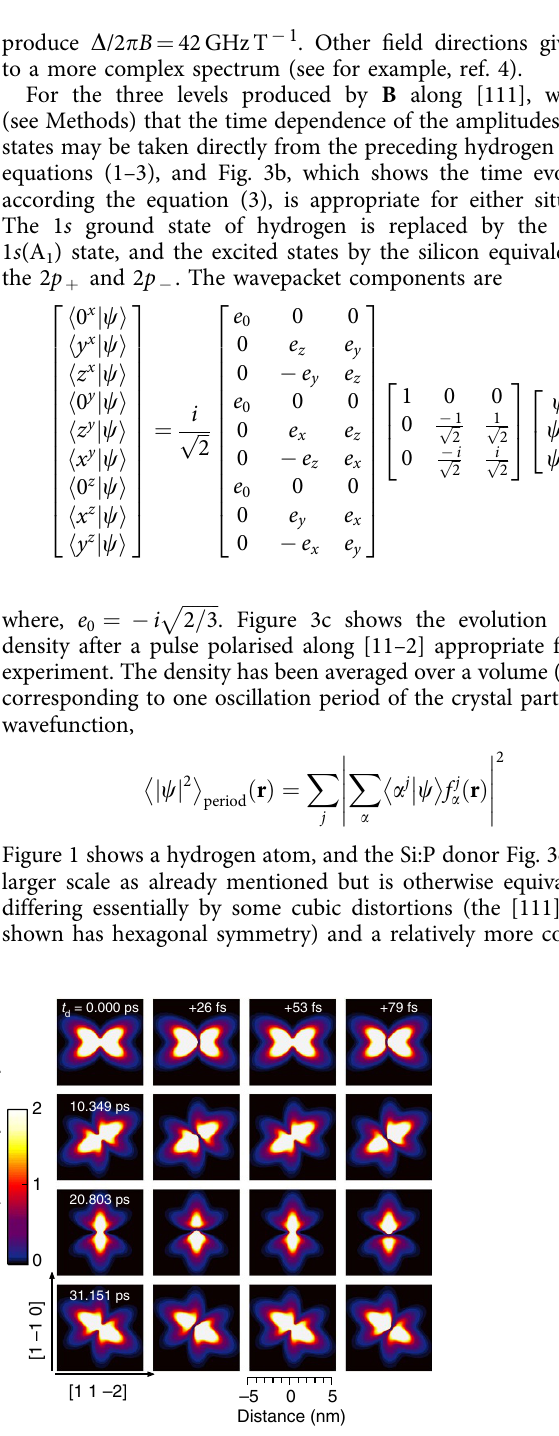
Figure 3 | Time evolution of multi-valley donor states in silicon. Evolution through time of a multi-valley superposition of the 1 s (A 1 ) and 2 p ± states in Si:P for a magnetic field direction of [111]. ( a ) The calculated level spectrum in the low field limit and B along [111]. ( b ) The absorption equation (3) (no dephasing) as a function of delay for a pair of linearly polarized pulses of equal area O t p ¼ ay 0 each, where y 0 ¼ O 2 p /4 for different values of a according to the legend ( a ¼ 1 corresponds to both pulses having area equal to the illustration in Figs 1d and 3c, and a ¼ 1/8 corresponds to the experimental condition in Figs 4,6 and 7 below). (For clarity, the fast oscillation at 9.47THz has been aliased down by a factor 50 by under sampling). ( c ) The probability density shown in the plane perpendicular to the field. The superposition is initiated at t ¼ 0 by a delta-function pulse polarized along [11–2], reducing the probability of occupation of the ground state to 50% which may be produced by a uniform illumination of pulse of energy of 10 m J duration 10ps, and spot size of 1cm (equivalent to the unfocussed laser beam). The density has been spatially averaged over the quickly varying oscillations due to valley interference. The probability density was normalized in each frame so that the probability of finding the electron in a region with P Z 1 is 50%. Thus the red contour encloses 50% of the integrated probability density. The labelled times t d are shown in ps, equivalent to the phases shown in Fig. 1, that is, D t d ¼ n p /2 and o t d ¼ m p /2, where n and m index rows and columns, respectively, and range from 0 to 3. In this example, the Zeeman splitting is 2 D ¼ 24.2GHz, which occurs for | B | ¼